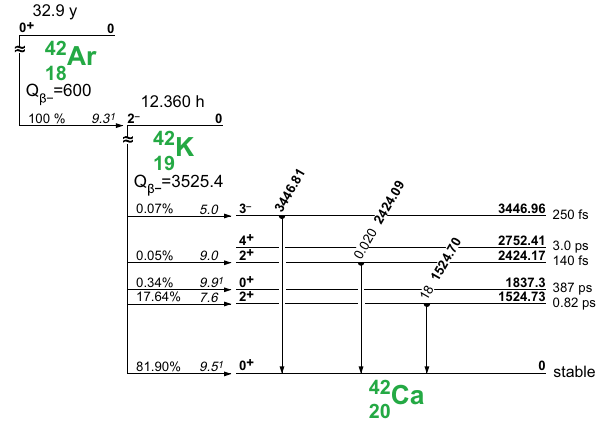
Fig. 1 Simplifieddecayschemeof 42 Ar[5].The1525keVgammaline is used to identify 42 K